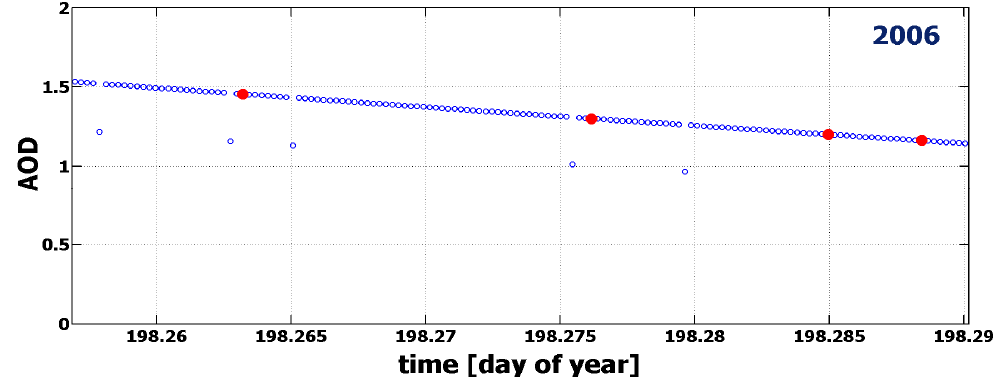
Table 1. The total number of points with “good” and “bad” MFRSR AODs (at 0.5 μ